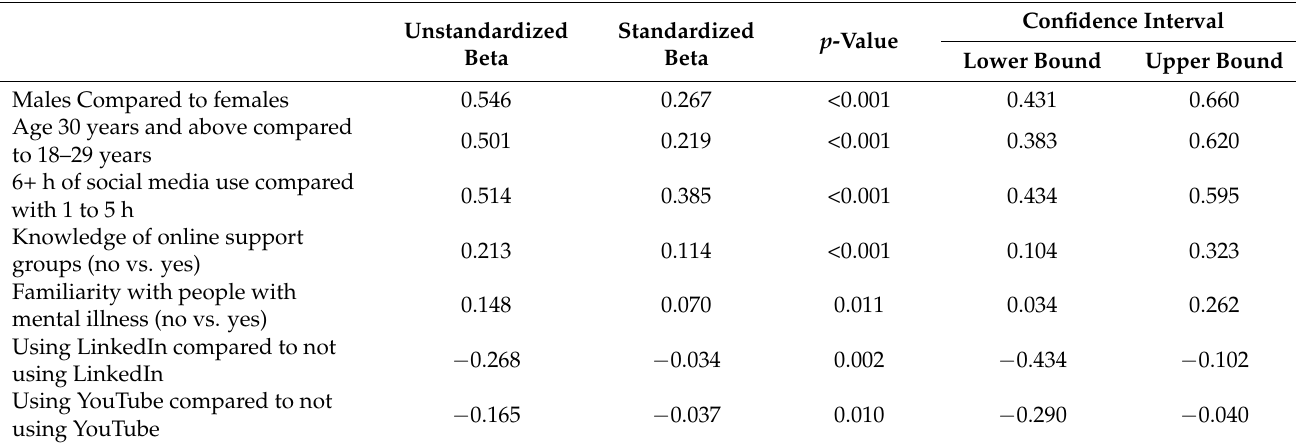
Table 7. Multivariable analysis of the Middle Eastern